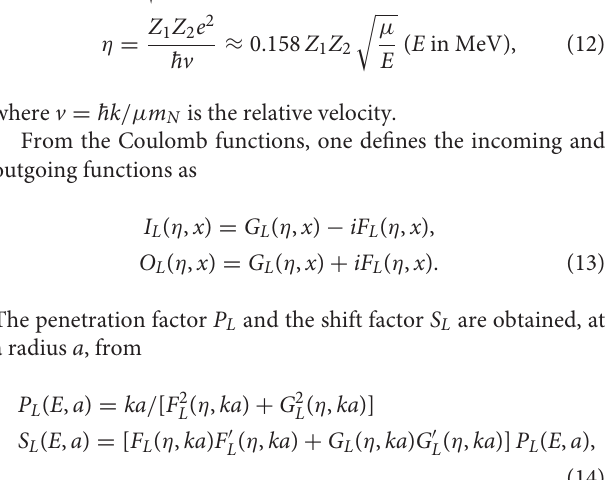
Frontiers in Astronomy and Space Sciences |